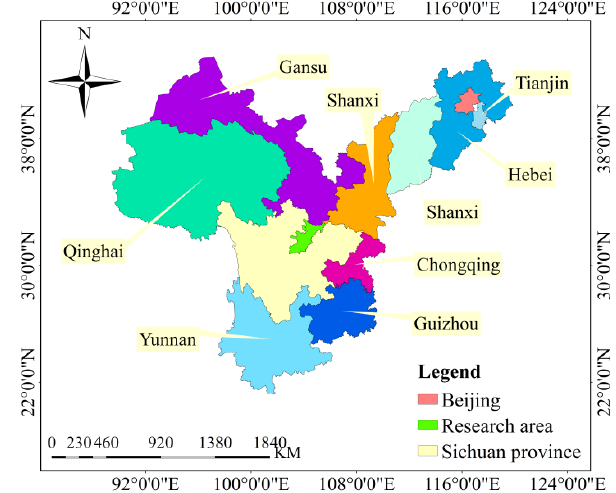
Figure 1. Map of the research area location.